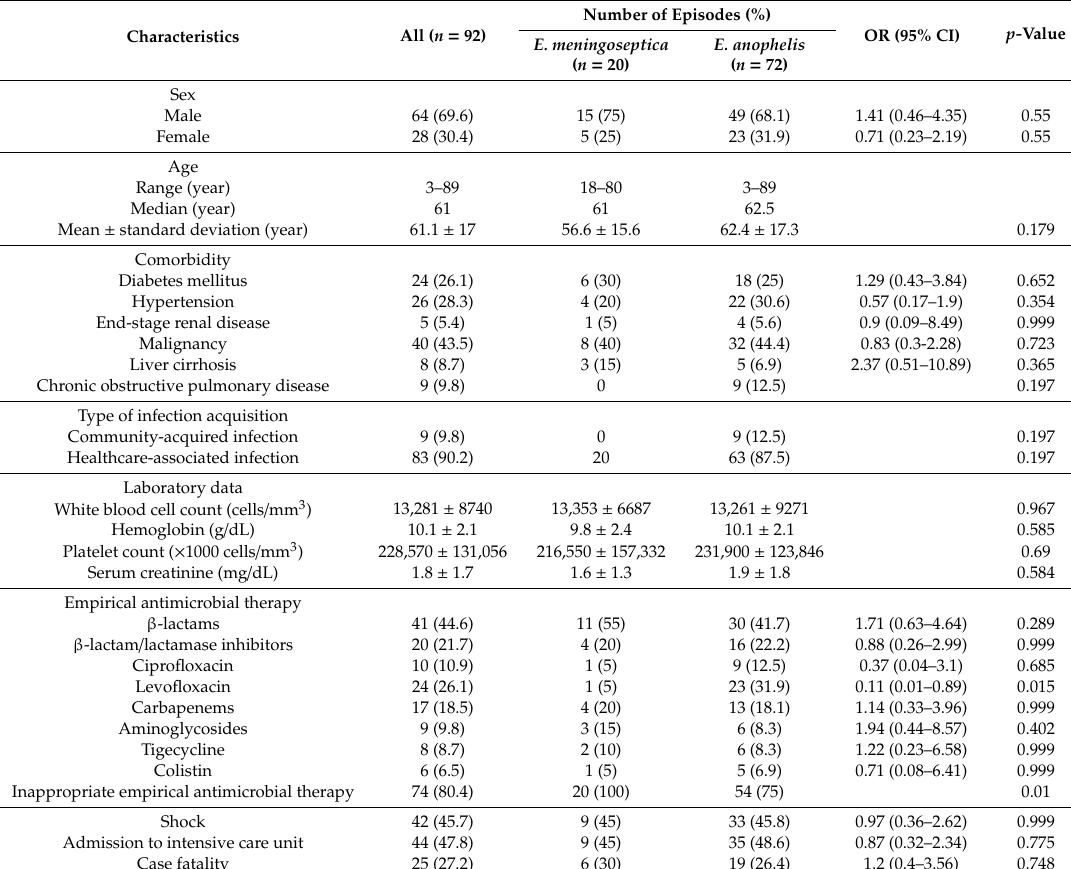
Demographic characteristics, clinical information, and outcome of patients with E. meningoseptica and E. anophelis